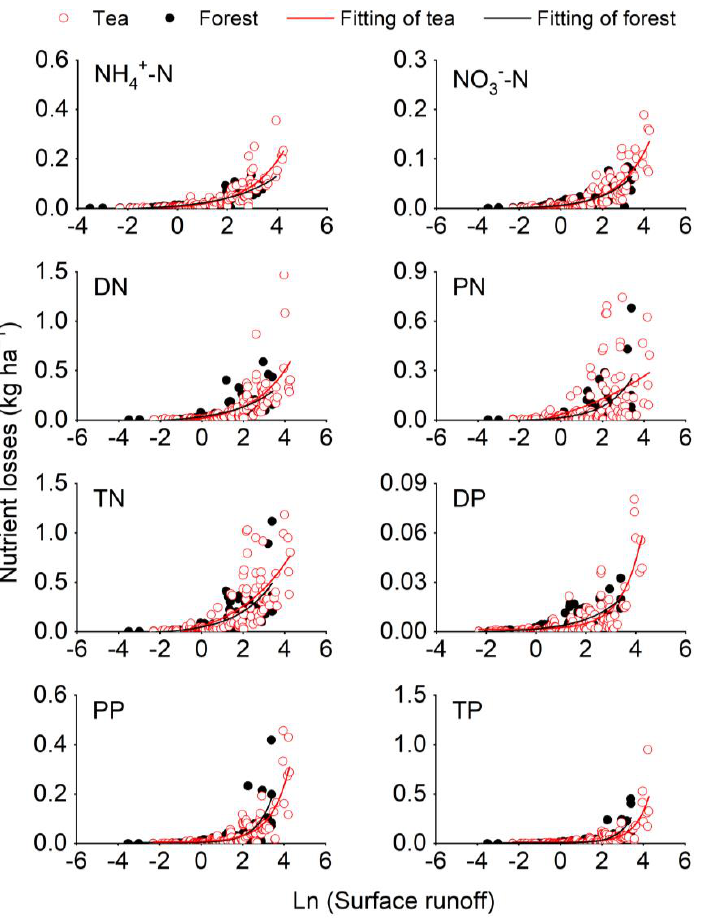
Figure 6. Exponential fitting between the surface runoff after the hyperbolic logarithm transformation (ln(surface runoff)) and the nitrogen and phosphorus losses at the rain event basis in the tea and forest systems.